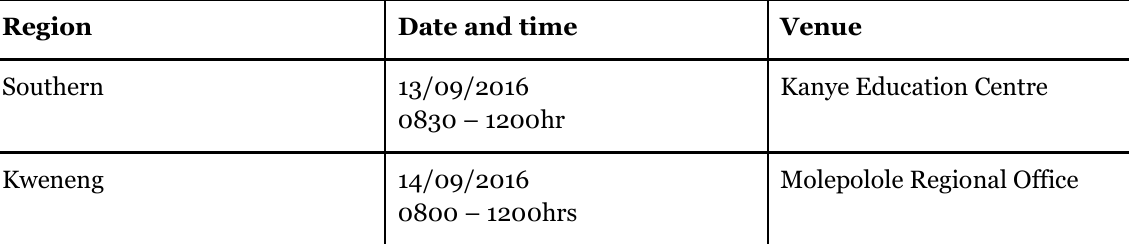
Field Visit Schedule for the 10 Regions of